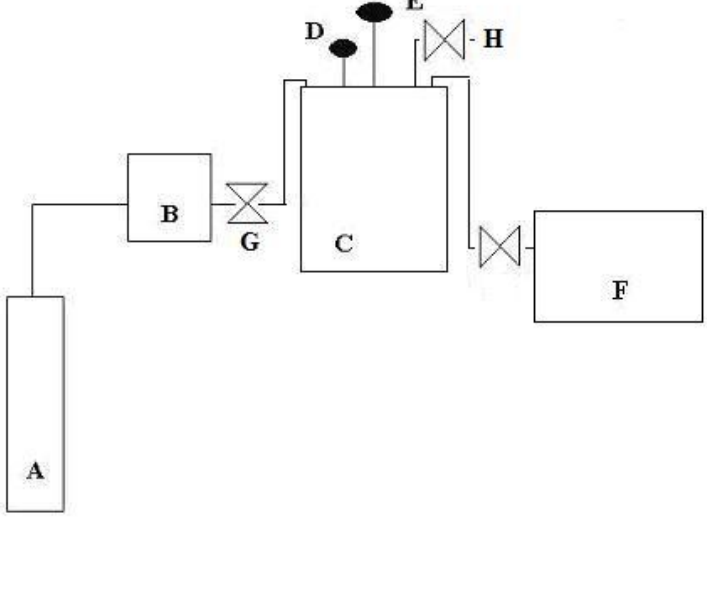
Figure 4. Schematic illustration of the experimental apparatus: A, CO pump; C, reactor; D, temperature controller; E, pressure transducer; F, air compressor, G cold trap; H, sampler tube and